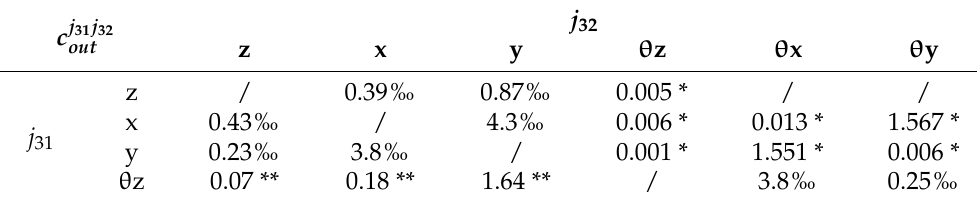
Table 7. Output coupling ratio of the 6-RRRR NPS using the